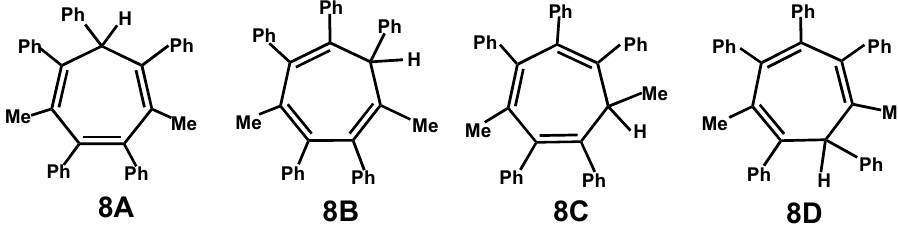
Figure 7. The four possible isomers of 8 , arising from [1,5]-hydrogen shifts upon ring-opening of the Diels-Alder adduct of triphenylcyclopropene and 2,5-dimethyl-3,4-diphenylcyclopentadienone.